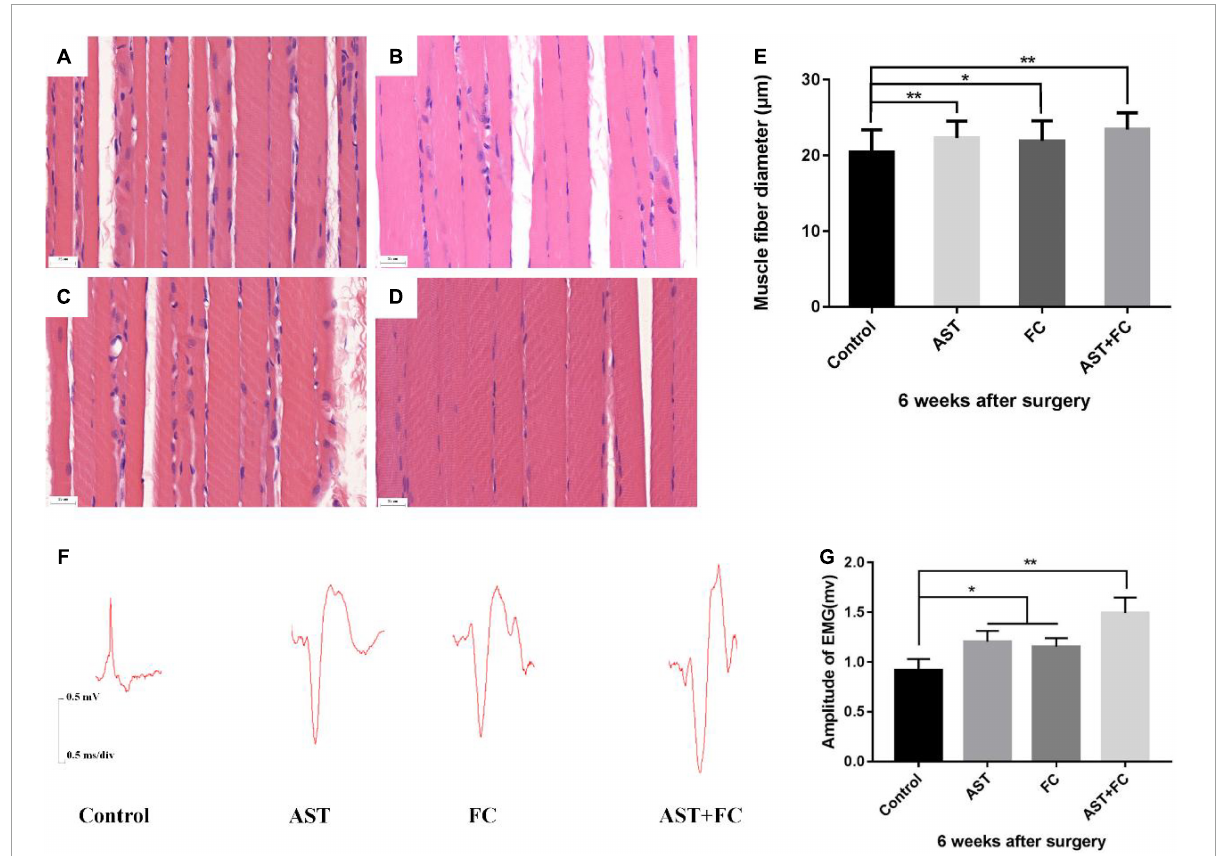
FIGURE5 Diameters of biceps myofibers and the amplitude of compound action potential of musculocutaneous nerve-biceps on the injured side at 6 weeks after BPA. (A–D) Diameters of biceps myofibers from the control, AST, FC, and AST + FC groups ( n = 3, bar = 20 µ m). (E) Statistical comparison of the diameters from the above 4 groups (* p < 0.05, ** p < 0.01). (F) Compound action potentials of musculocutaneous nerve-biceps in control, AST, FC, and AST + FC groups at 6 weeks after BPA. (G) Statistical analysis of amplitudes of compound action potentials from the 4 groups ( n = 3, * p < 0.05, ** p <